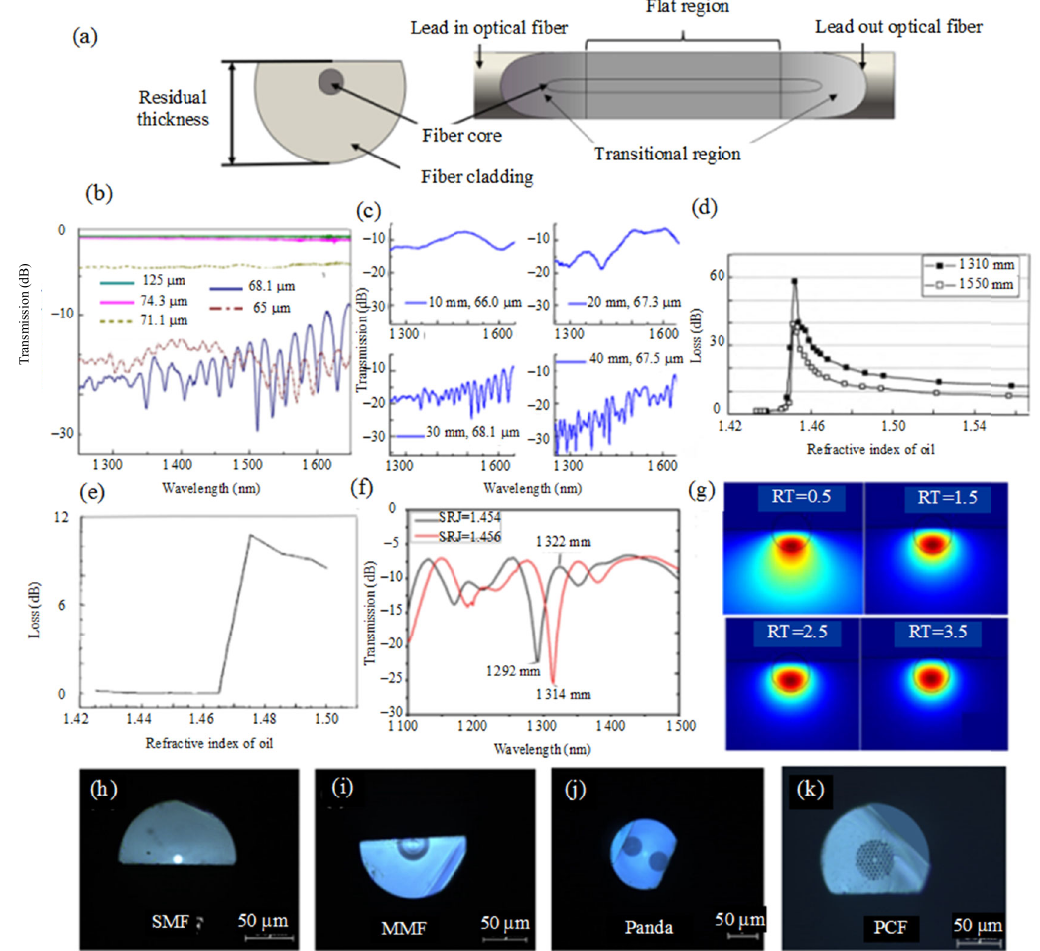
Fig. 2 Char evolution of th spectrums of d of transmission the optical